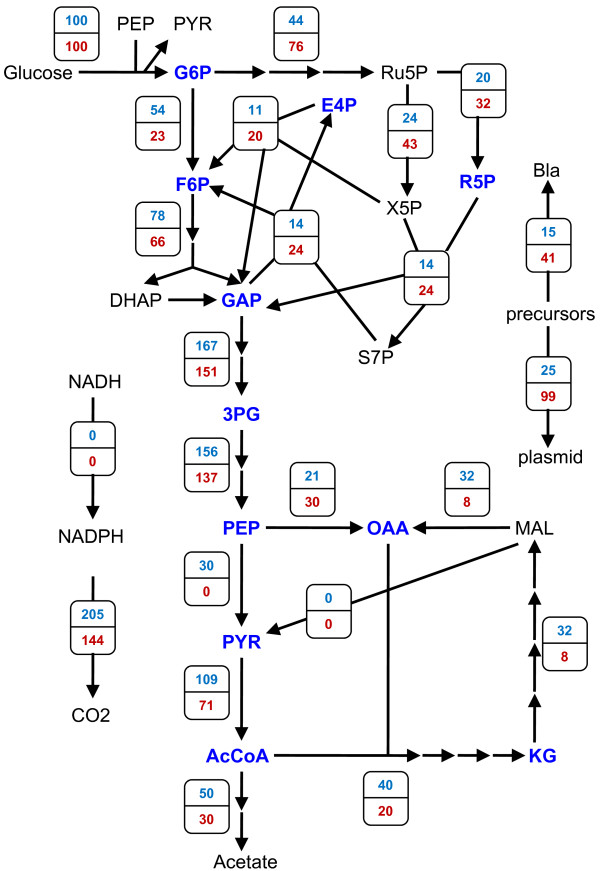
Maximum plasmid-producing flux distributions for the JM101 and PB25 models. For both distributions, α = 250 in Equation (5), and rtranshydrogenase was constrained to zero. Equations (8) and (9) were employed to constrain racetate and rPyk to experimental values for JM101 (wild-type) and PB25 (pykF pykA). Top: JM101. Bottom: PB25. For simplicity, the network in Fig. 1 has been condensed and fluxes (mmol/g/h) have been expressed as % of glucose uptake, except rBla (expressed as % of total protein) and rplasmid (expressed as yield in mg/g). The production of lactate and succinate have also been omitted, as these fluxes were nil for all distributions.